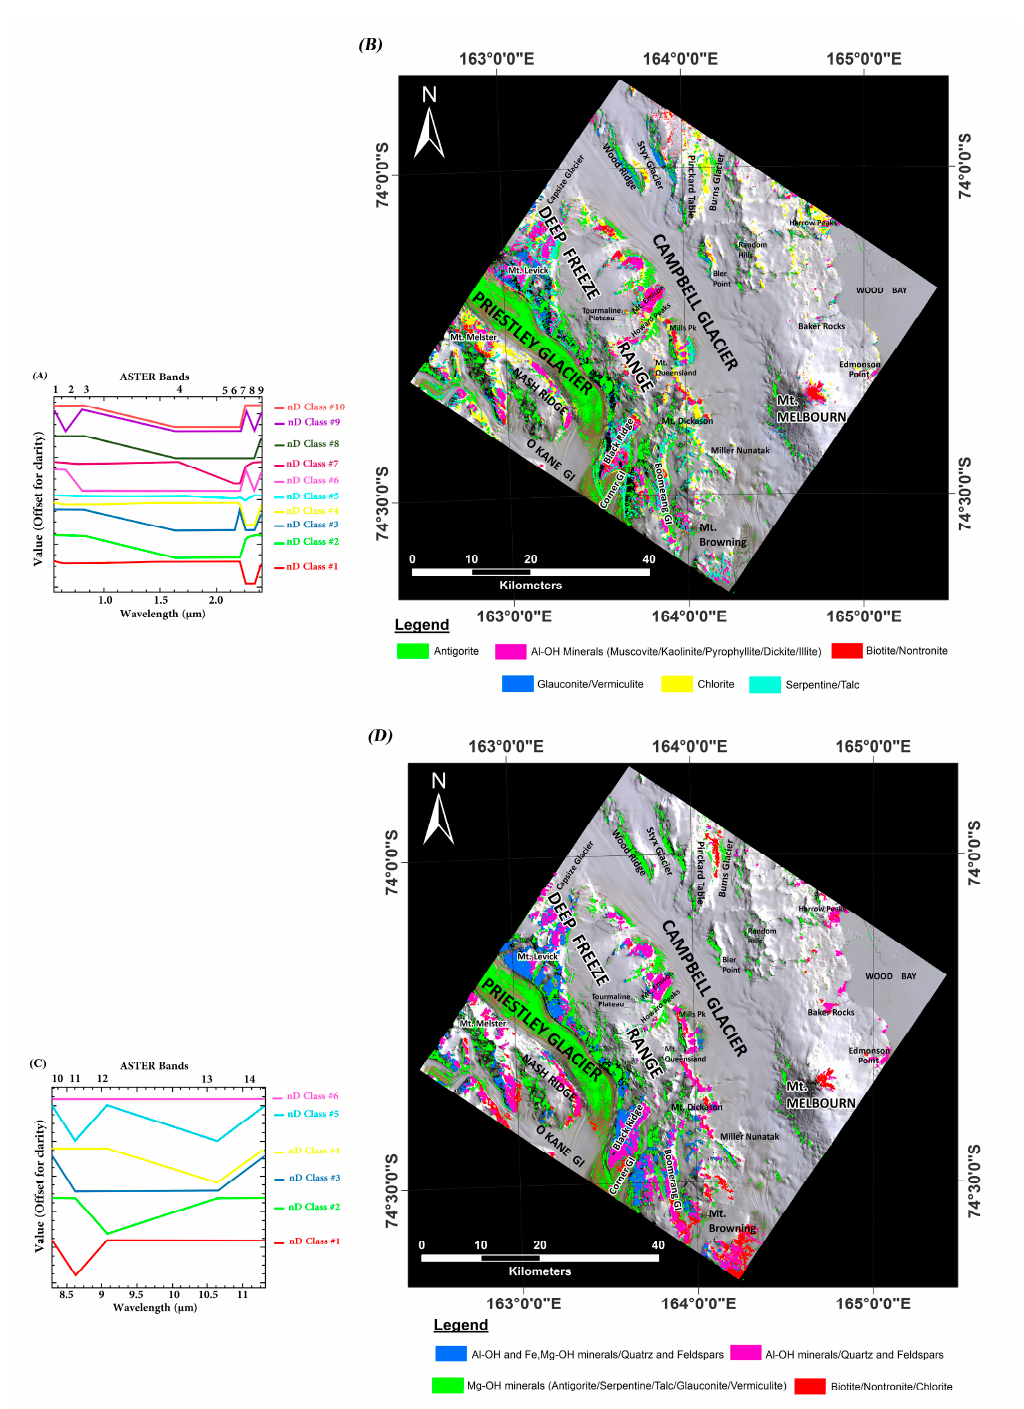
Figure 8. ( A ) Endmember spectra extracted from ASTER VINR+SWIR bands using the n-Dimensional analysis technique FIG 8 for the Campbell Glacier (II). ( B ) MTMF classification mineral maps derived from MF score images (VINR+SWIR bands) for the Campbell Glacier (II) scene. ( C ) Endmember spectra extracted from ASTER TIR bands using the n-Dimensional analysis technique for the Campbell Glacier (II). ( D ) MTMF classification mineral maps derived from MF score images (TIR bands) for the Campbell Glacier (II)